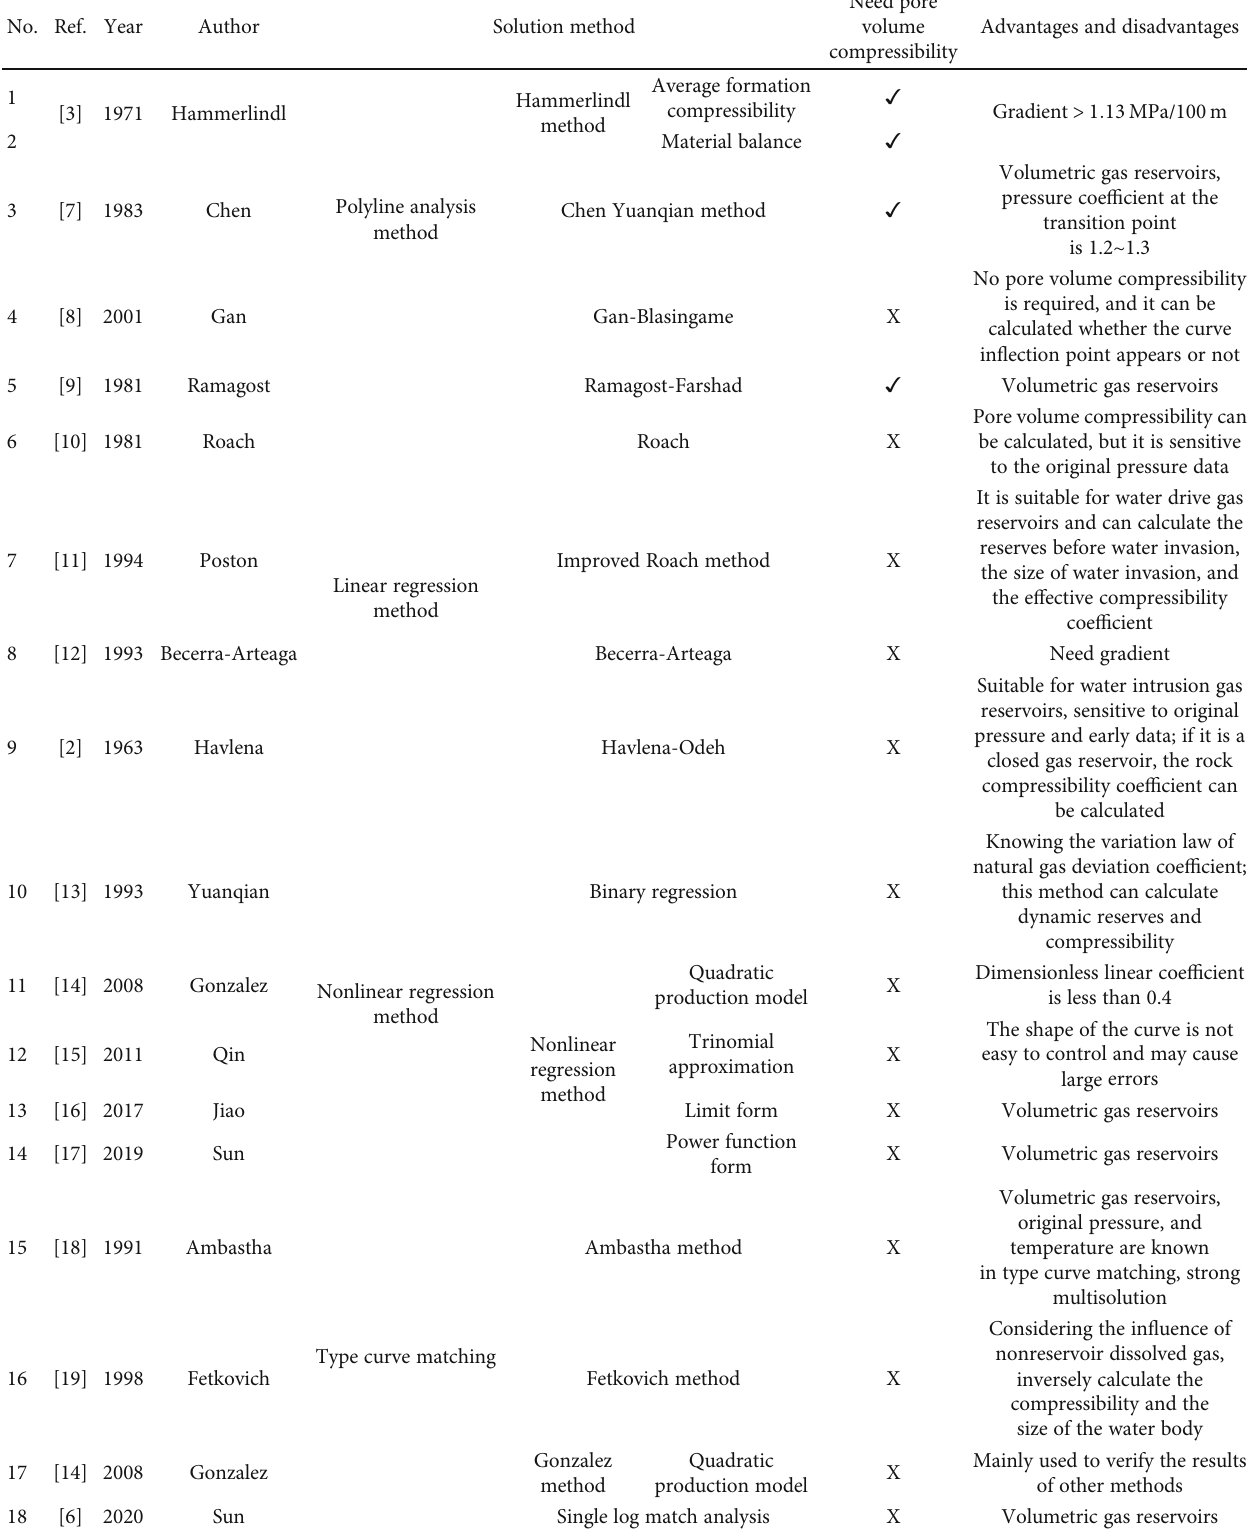
Table 1: Published studies of reserve estimate problem of high pressure gas